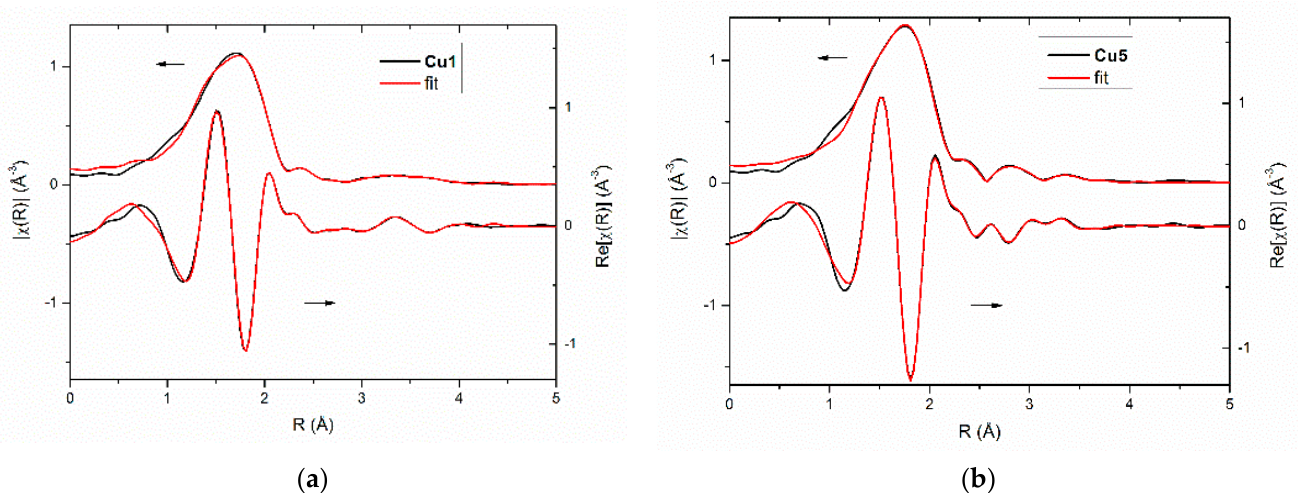
Figure 7. The best fits together with FT EXAFS oscillations of complexes: ( a ) Cu1 and ( b ) Cu5 . The study of complexes within group A indicates four atoms within the first coordination sphere (Table 2), two N and two S atoms. The Cu–N/S bond length is in the range 1.93–1.95 Å for nitrogen and 2.23–2.25 Å for sulfur atoms. Moreover, at a distance of around 2.5 Å, two carbon atoms were identified. Table 2. The distance from central cation to next atom R, number of atoms n , Debye–Waller factor σ 2 and R -factor of the fit evaluated during the final EXAFS fitting procedure. For clarity, only the main parameters for the closest neighbors are presented. Complex